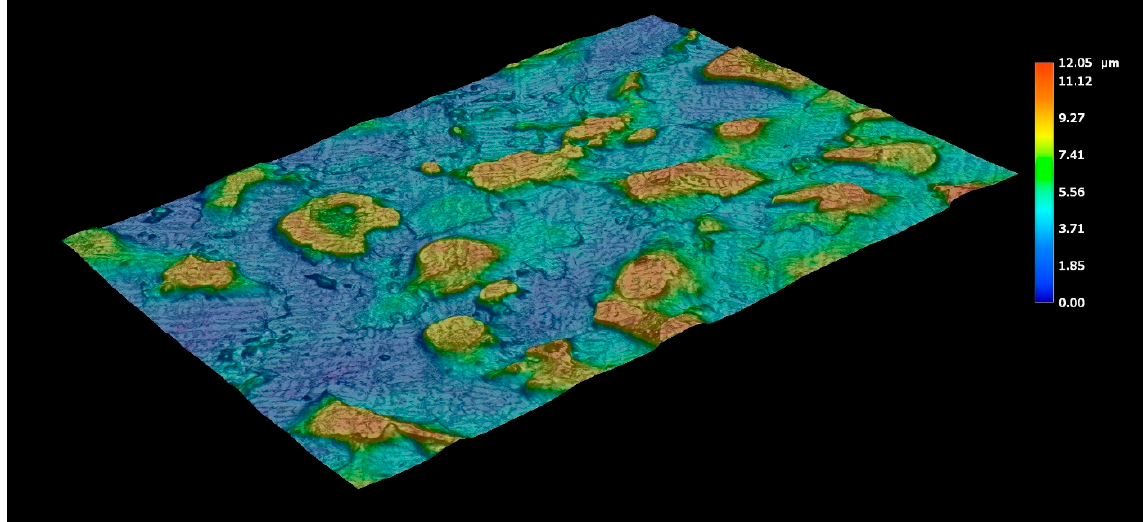
Materials 2021 , 14 , x Figure 14. The topography profile of the Al-Si hot-dipped coating on as-received 22MnB5 boron steel.